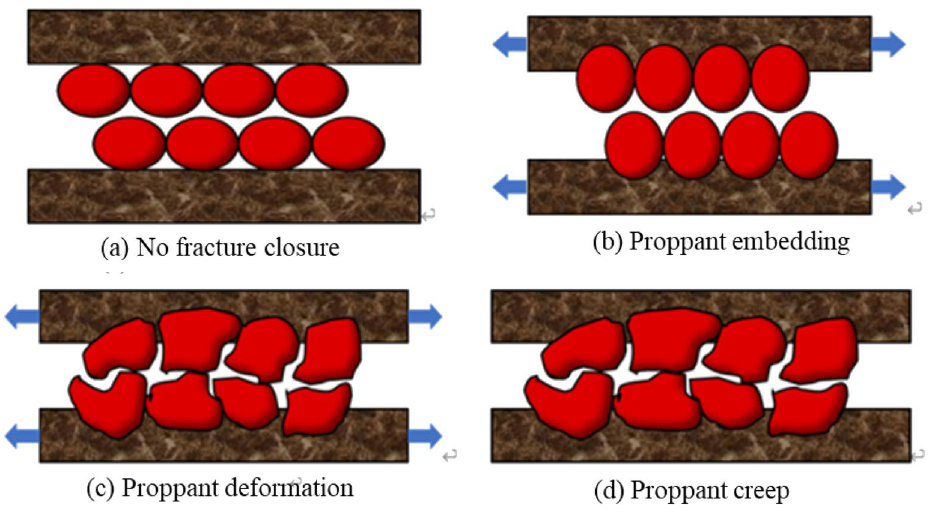
Figure 1. Schematic diagram of crack width change 9